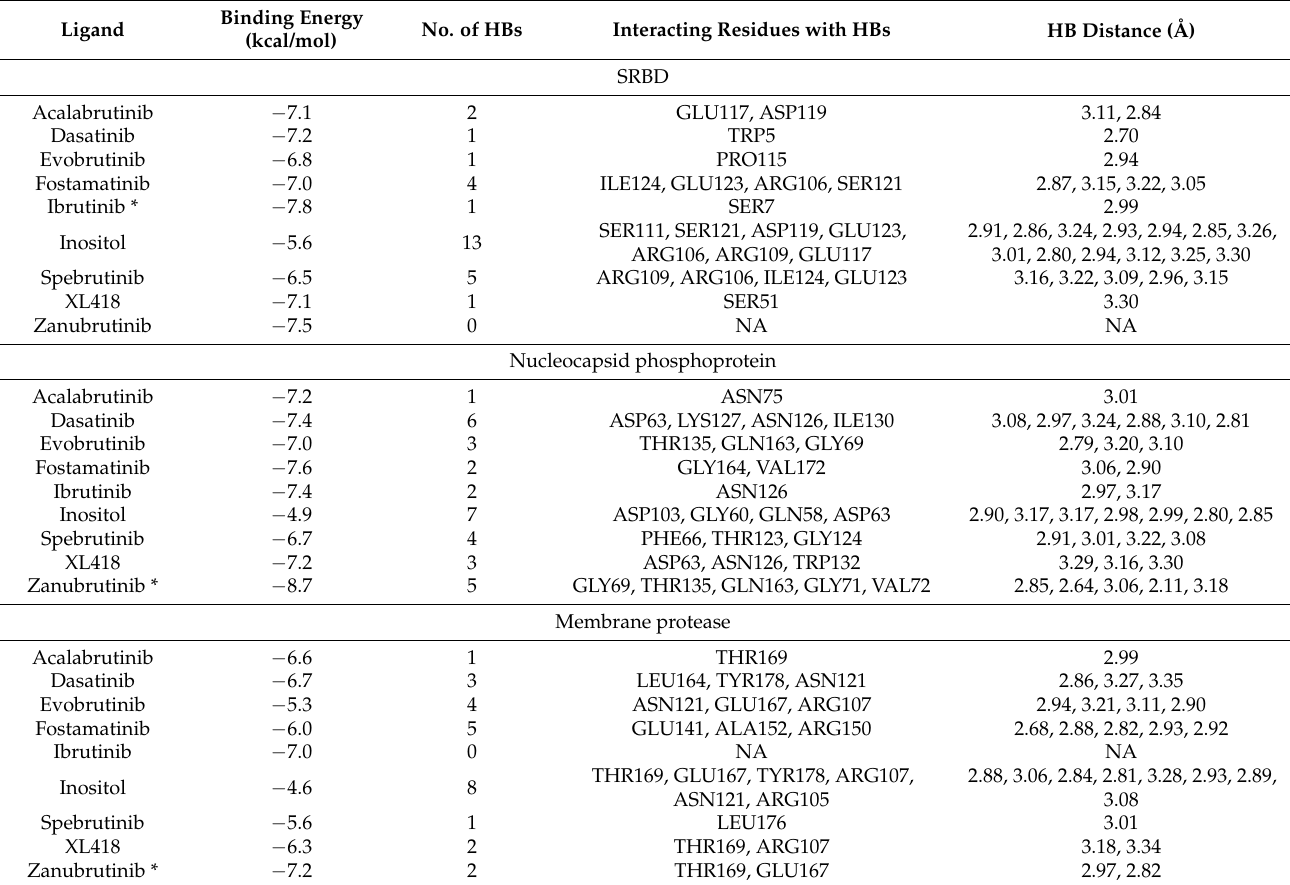
Table 2. Molecular binding interactions of the selected drugs with the structural proteins (SRBD, membrane protein and nucleocapsid phosphoprotein) of